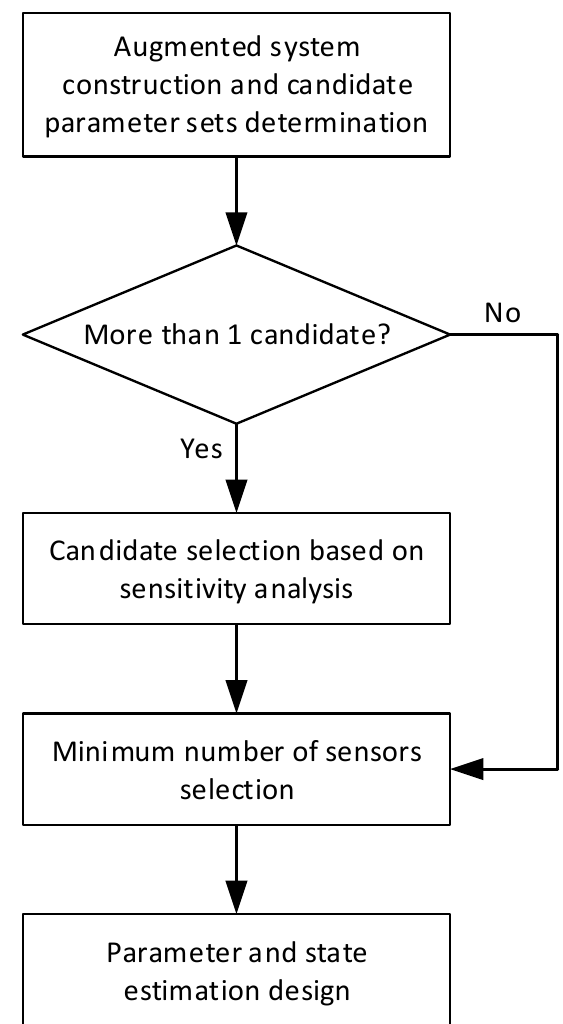
Figure 2. A flowchart of the procedure to determine the significant parameters and number of